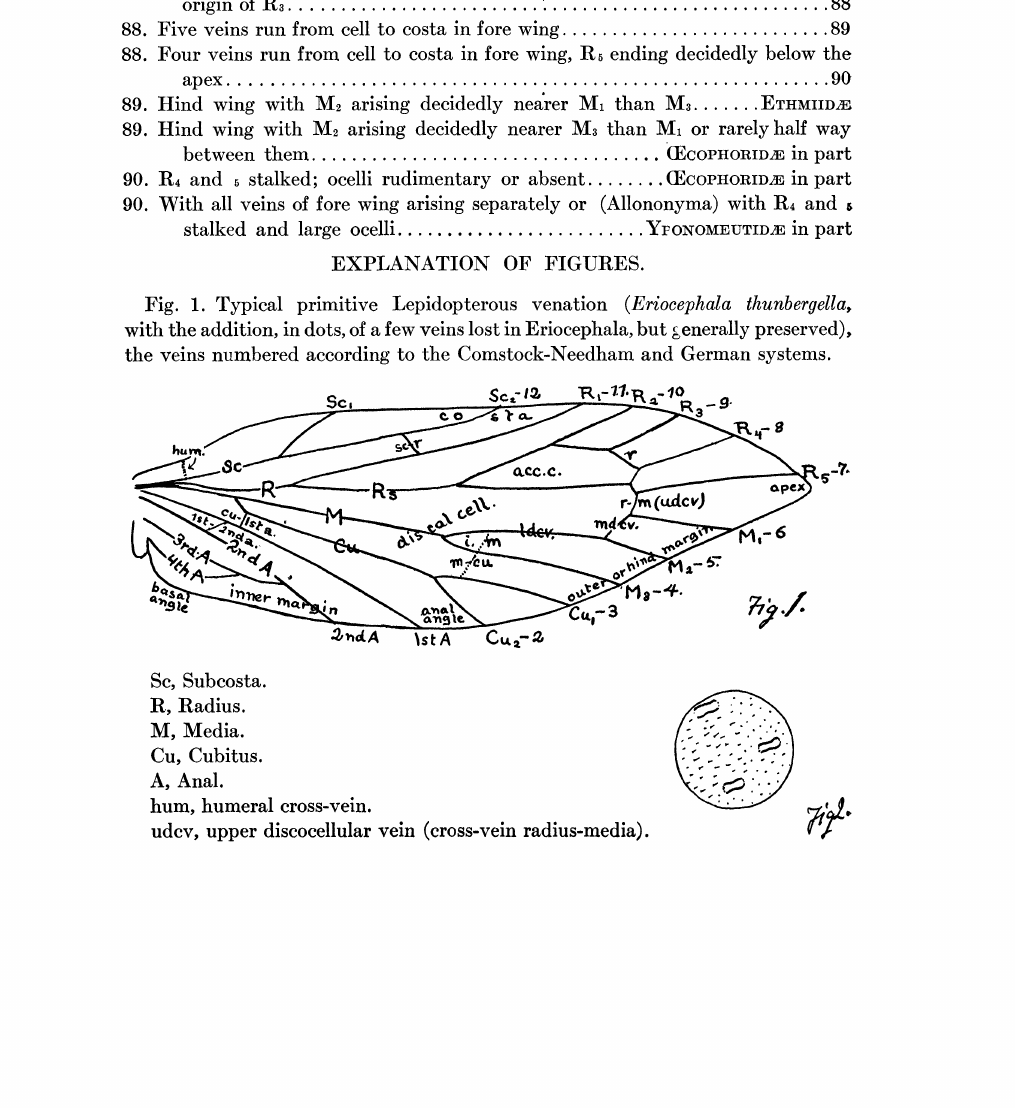
Fig. 1. Typical primitive Lepidopterous venation (Eriocephala thunbergella, with the addition, in dots, of a few veins lost in Eriocephala, but enerally preserved), the veins numbered according to the Comstock-Needham and German systems.